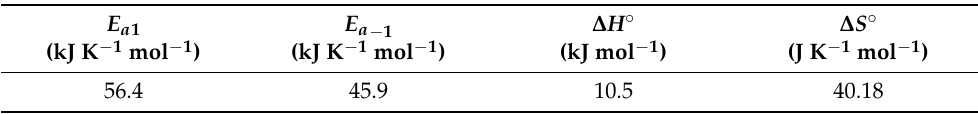
Table 2. E a 1 , E a − 1 , ∆ H ◦ and ∆ S ◦ evaluated for the direct-esterification reaction between LA and ethanol, catalyzed by AlCl 3 · 6H 2